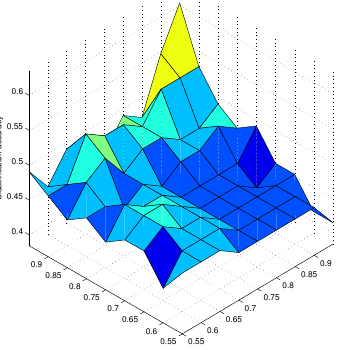
Figure 1. Classification accuracy for the glass